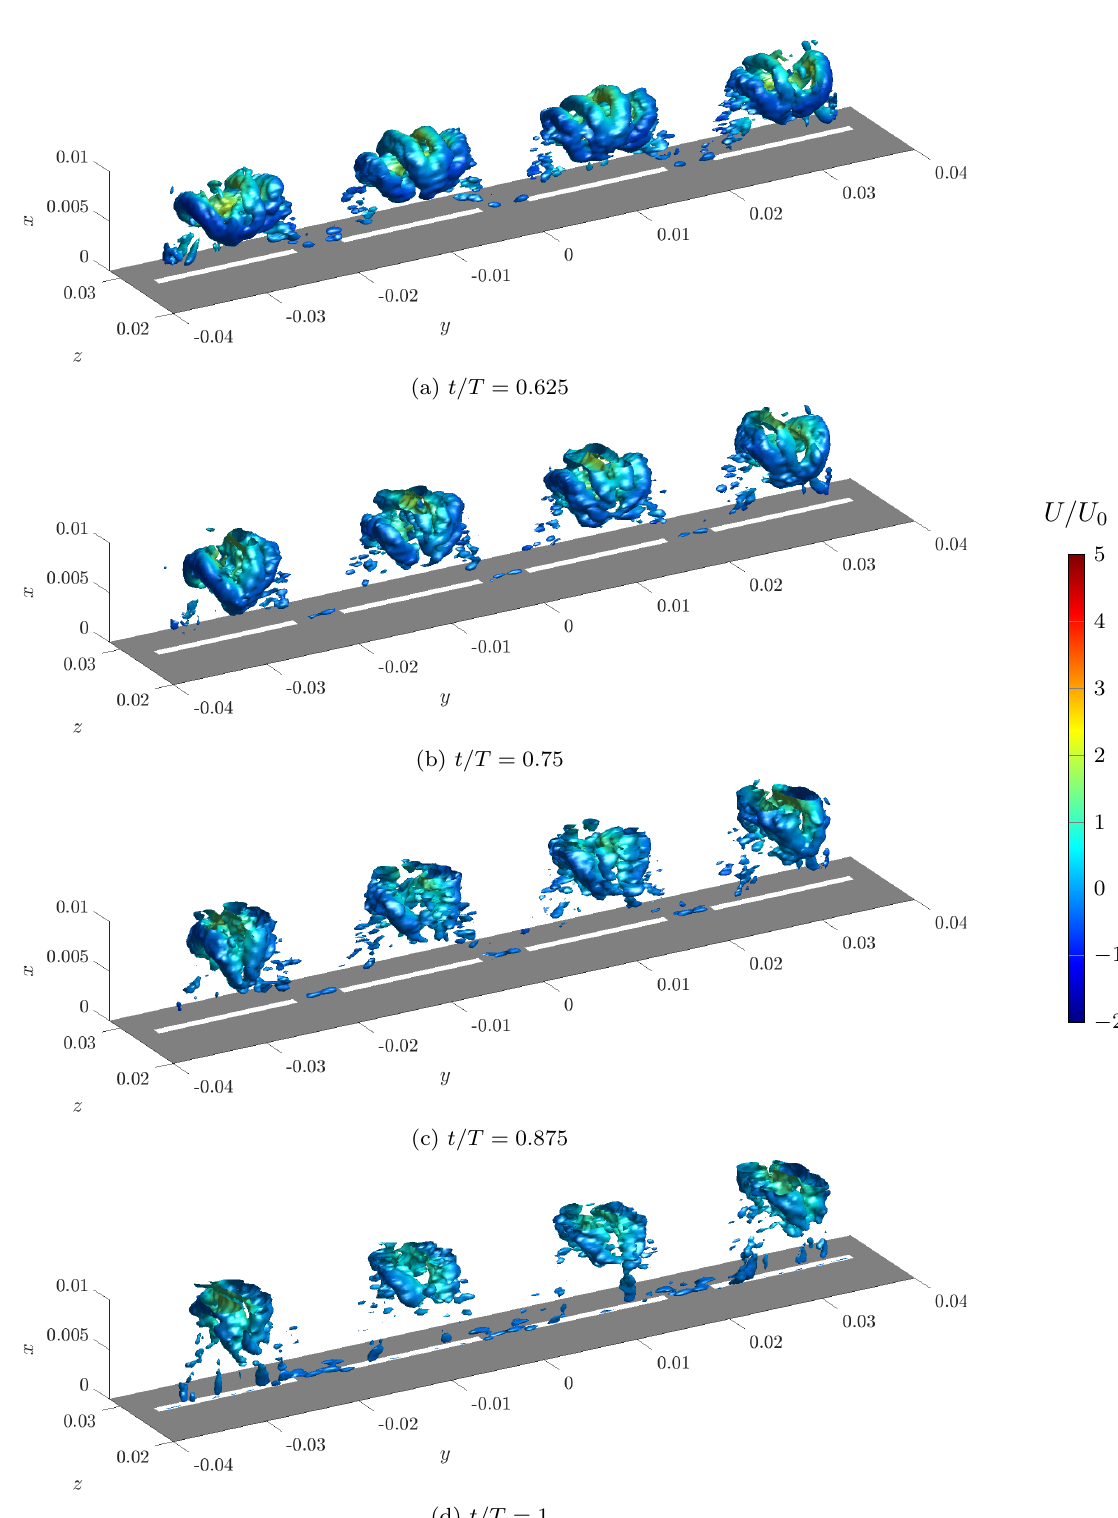
Figure 9. Evolution of the vortical structures in the near-field for the central slots, visualized by Q = 0.02 isosurfaces. Suction phase. The isosurfaces are colored with the phase-averaged streamwise velocity component U / U 0